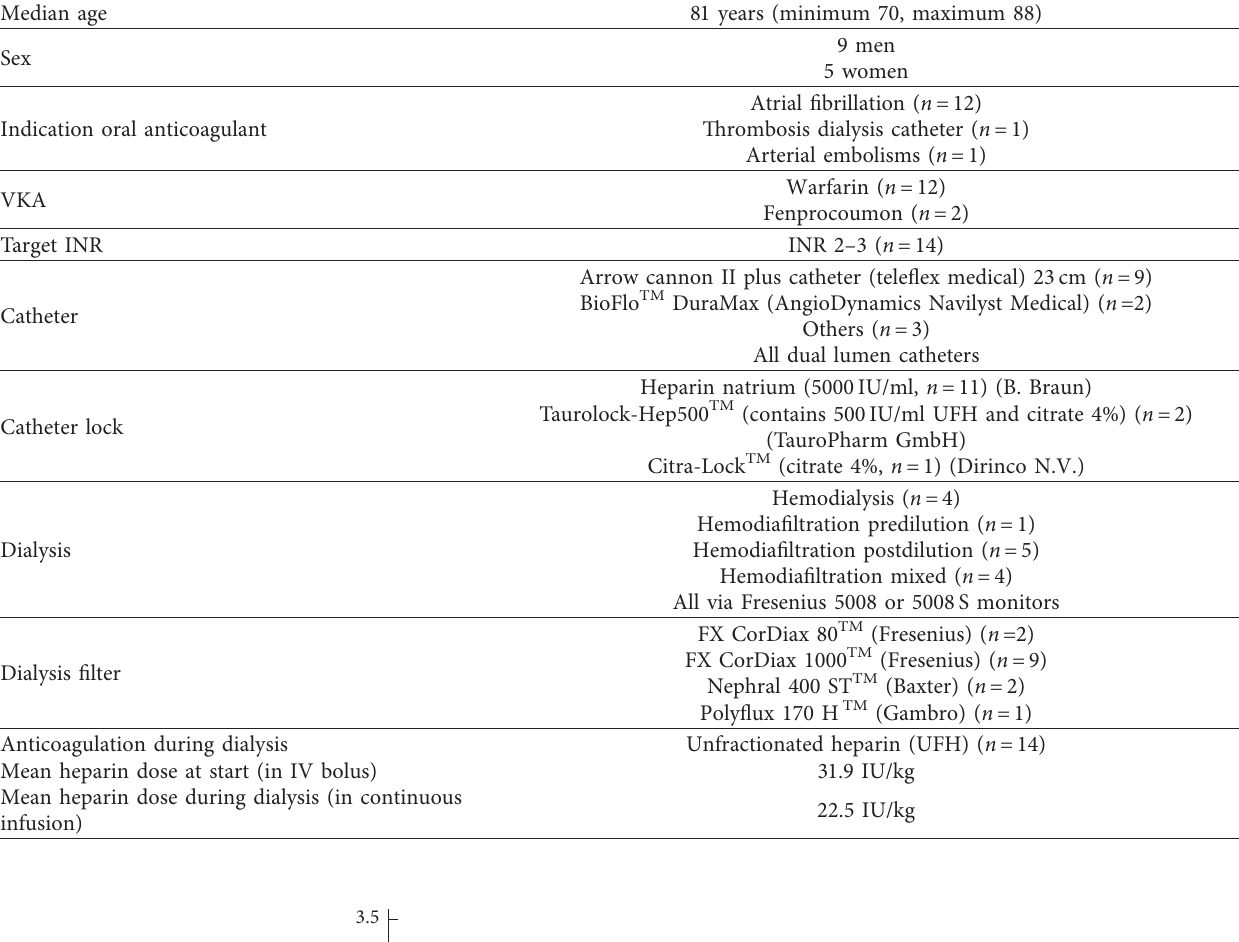
Table 1: Baseline clinical characteristics.